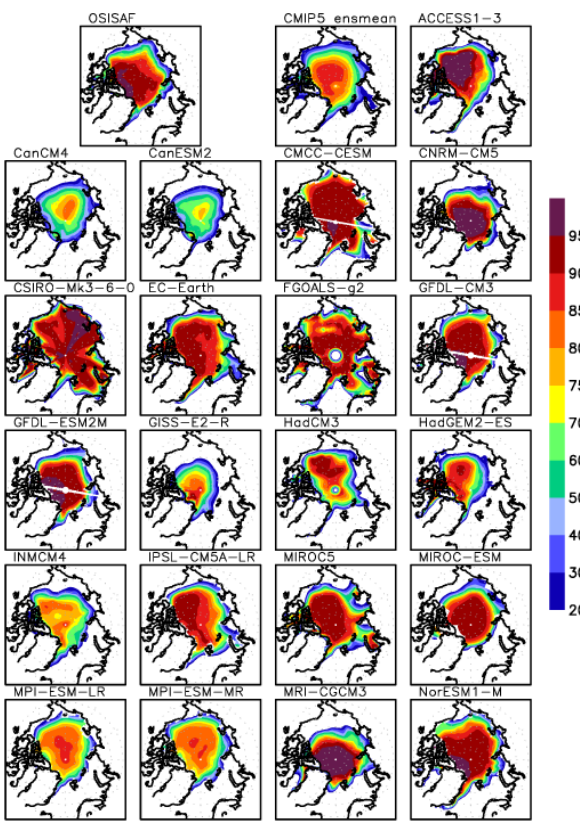
Fig. 3. September sea ice thickness in meters in the CMIP5 ensem- ble mean and individual CMIP5 models, averaged over the period